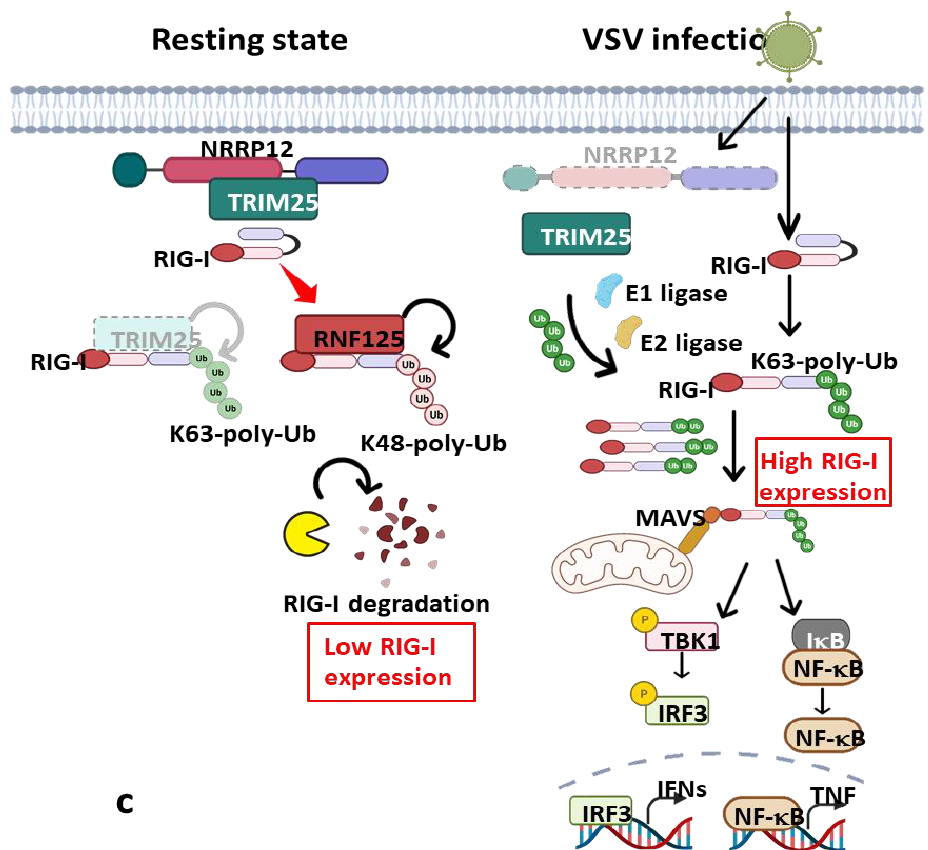
Figure 2. NLRP12 negatively regulates innate immune signaling in a pathogen-dependent manner. ( A ) NLRP12 inhibits IRAK1 and TRAF3/NIK to further inhibit canonical and noncanonical NF- κ B signaling and the MAPK/ERK inflammatory signaling pathway in bone marrow-derived macrophages (BMDMs). ( B ) NLRP12 participates in the recruitment of ASC for the processing of caspase 1 and maturation of IL-1 β and IL-18 to positively regulate innate host defense during Yersinia pestis and Plasmodium chabaudi. ( C ) NLRP12 associates with TRIM25 to reduce polyubiquitination of RIG-I and inhibits the RIG-I-mediated IFN response during VSV infection in bone marrow-derived dendritic cells. RIG-, Retinoic acid-inducible gene I; MAVS, Mitochondrial antiviral-signaling protein; TBK1, TANK-binding kinase 1.